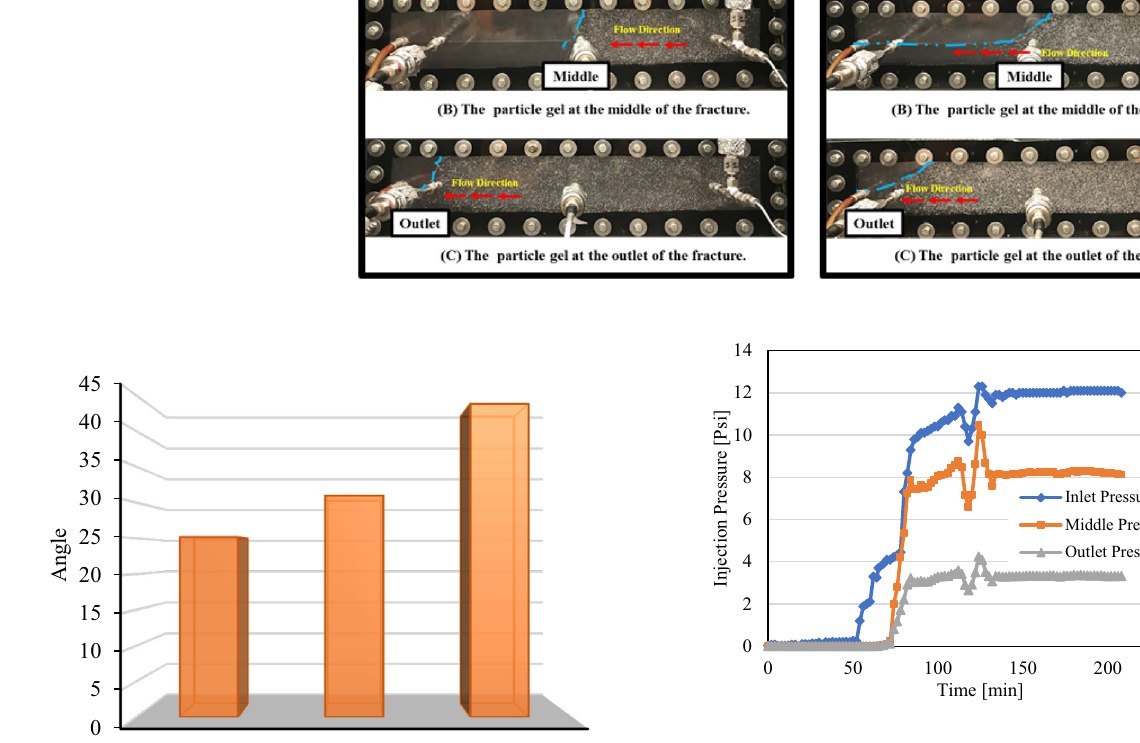
Fig. 7 Gel propagation through fractures: (I) gel particle size to fracture width ratio is 1.0 and (II) gel particle size to fracture width ratio is 0.47